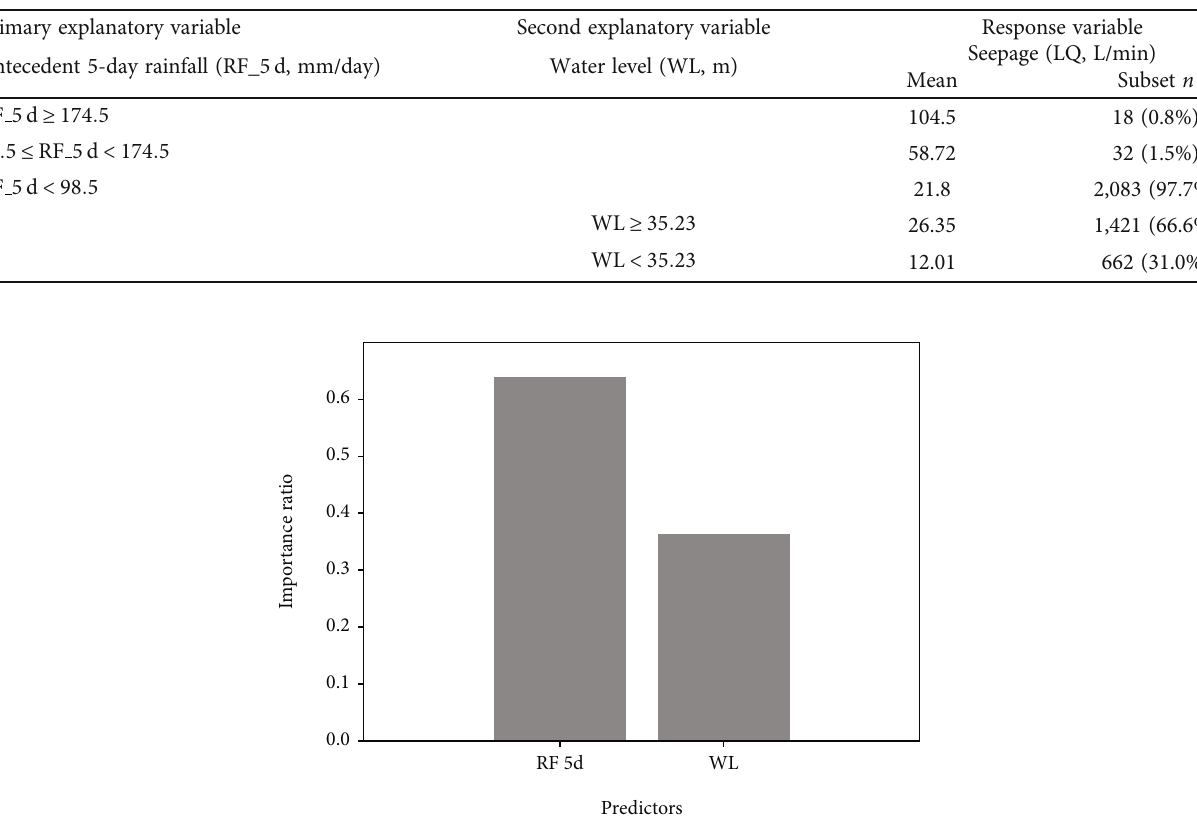
Table 4: Results of decision tress analysis for group A.